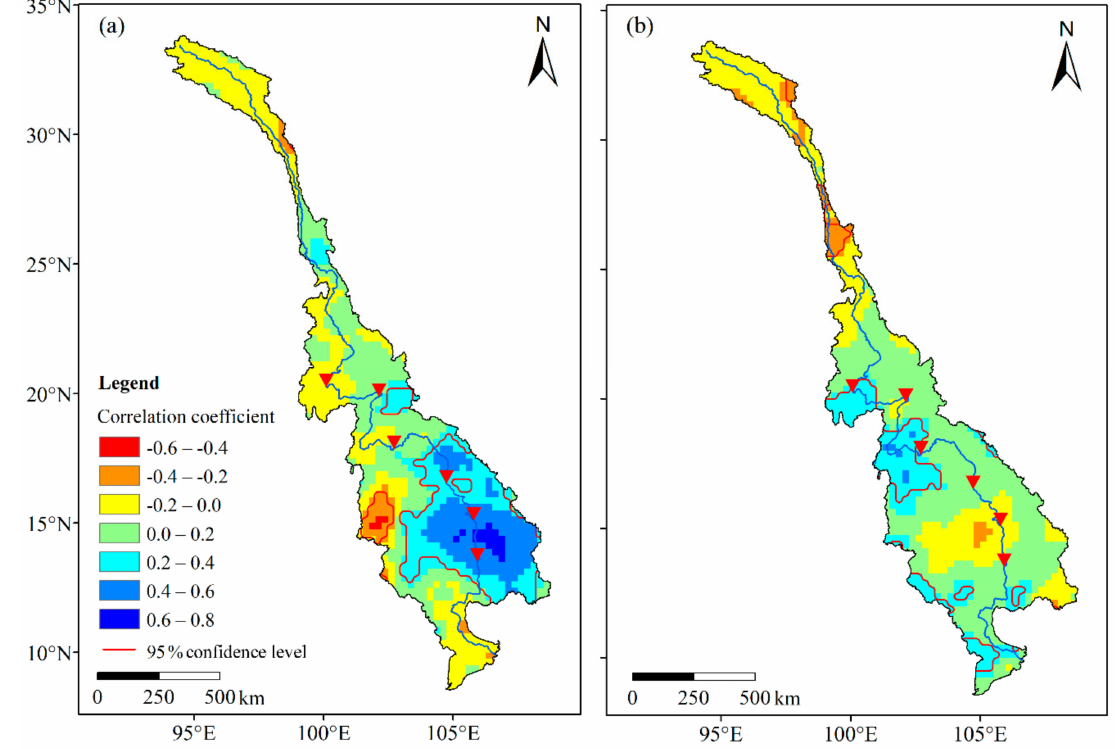
Figure 4. Correlation coe ffi cients between precipitation and monsoon index (( a ) western North Pacific summer monsoon index (WNPMI) and ( b ) Indian summer monsoon index (IMI)) during JJAS. In the regions enclosed by the red contour line, the correlation coe ffi cients of precipitation during JJAS between strong and weak monsoon years are statistically significant at the 95% confidence level. For the WNPMI, significant positive correlations mainly concentrate on the left bank of the downstream, while it would be on the right bank of the downstream for the